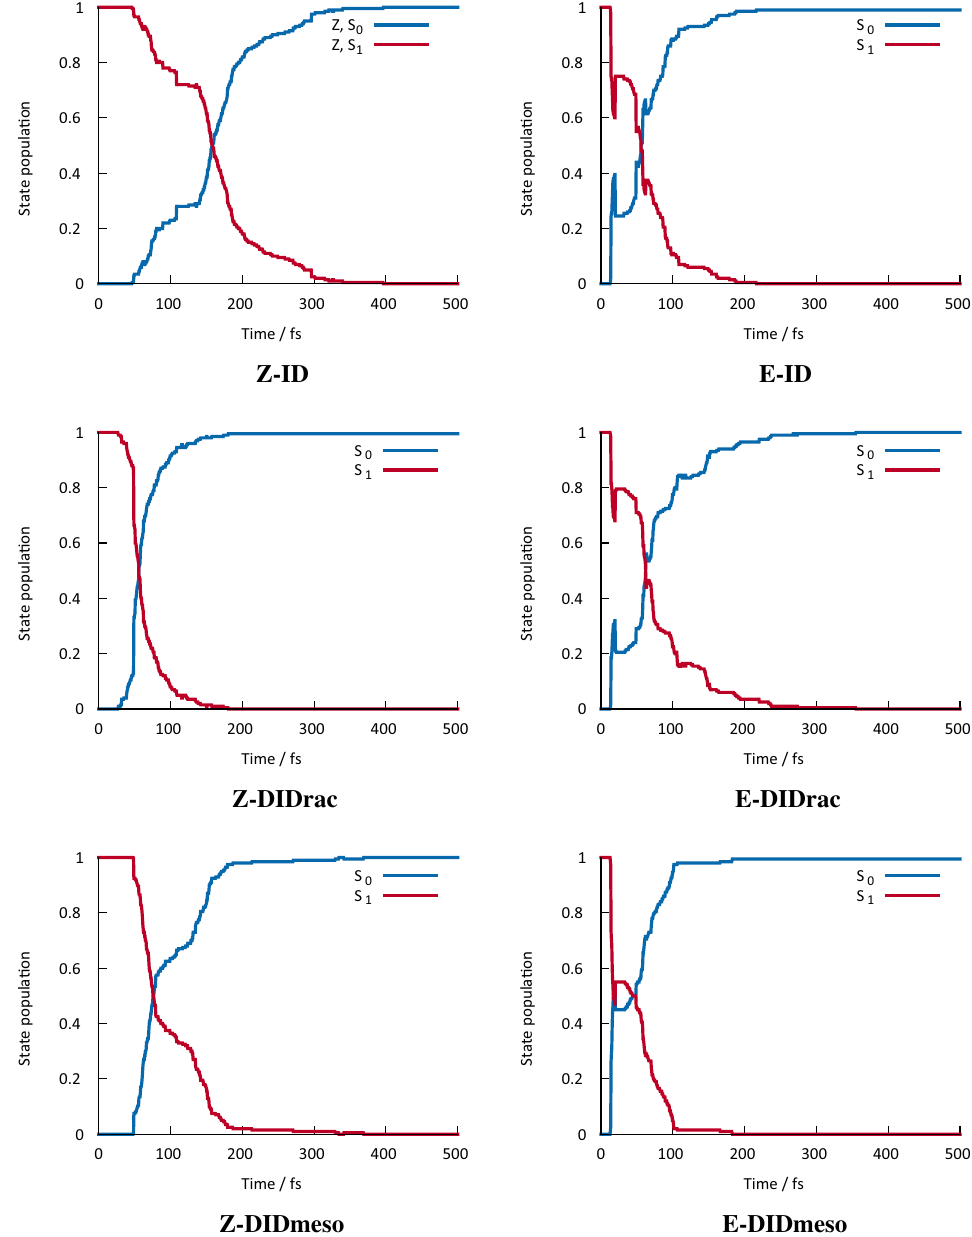
Figure 8. Ground- and excited-state populations for the studied compounds for the fi rst 500 fs. See Table 6 for the inversion